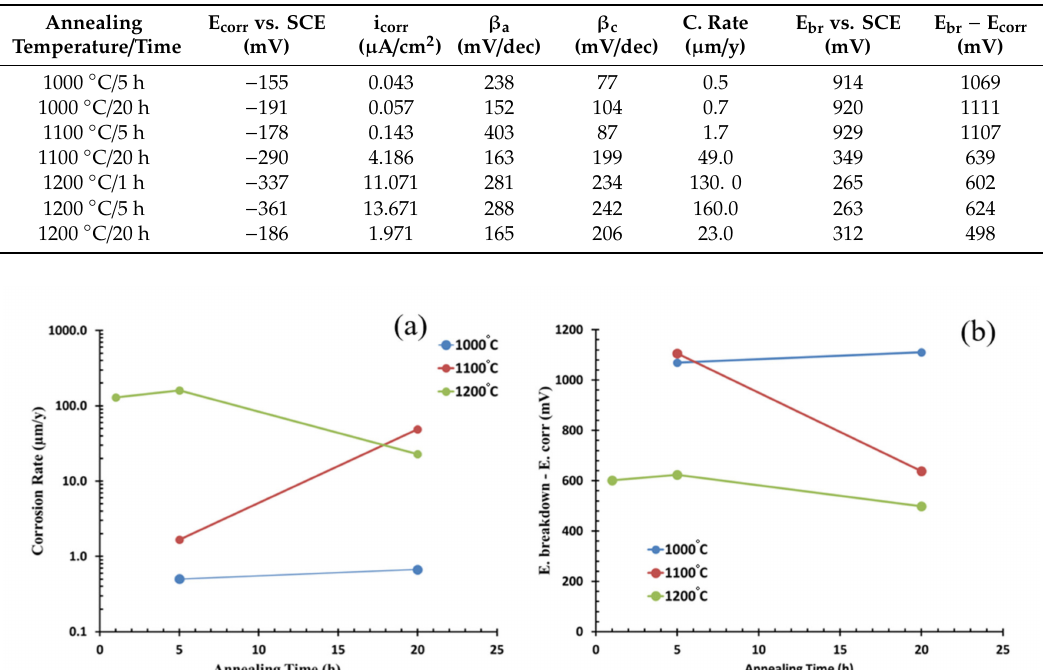
Table 2. Electrochemical data extracted from the polarization curves (Figure 6).